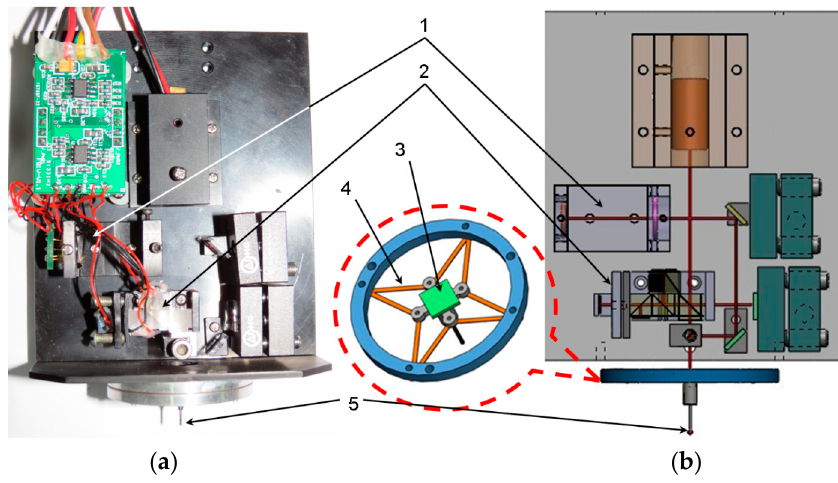
Figure 3. Physical and schematic structures of the 3D measuring probe. ( a ) physical picture of the probe; ( b ) schematic structure. 1: Autocollimator, 2: Michelson interferometer, 3: Mirror, 4: High sensitive elastic leaf spring, 5: Stylus with ruby ball.